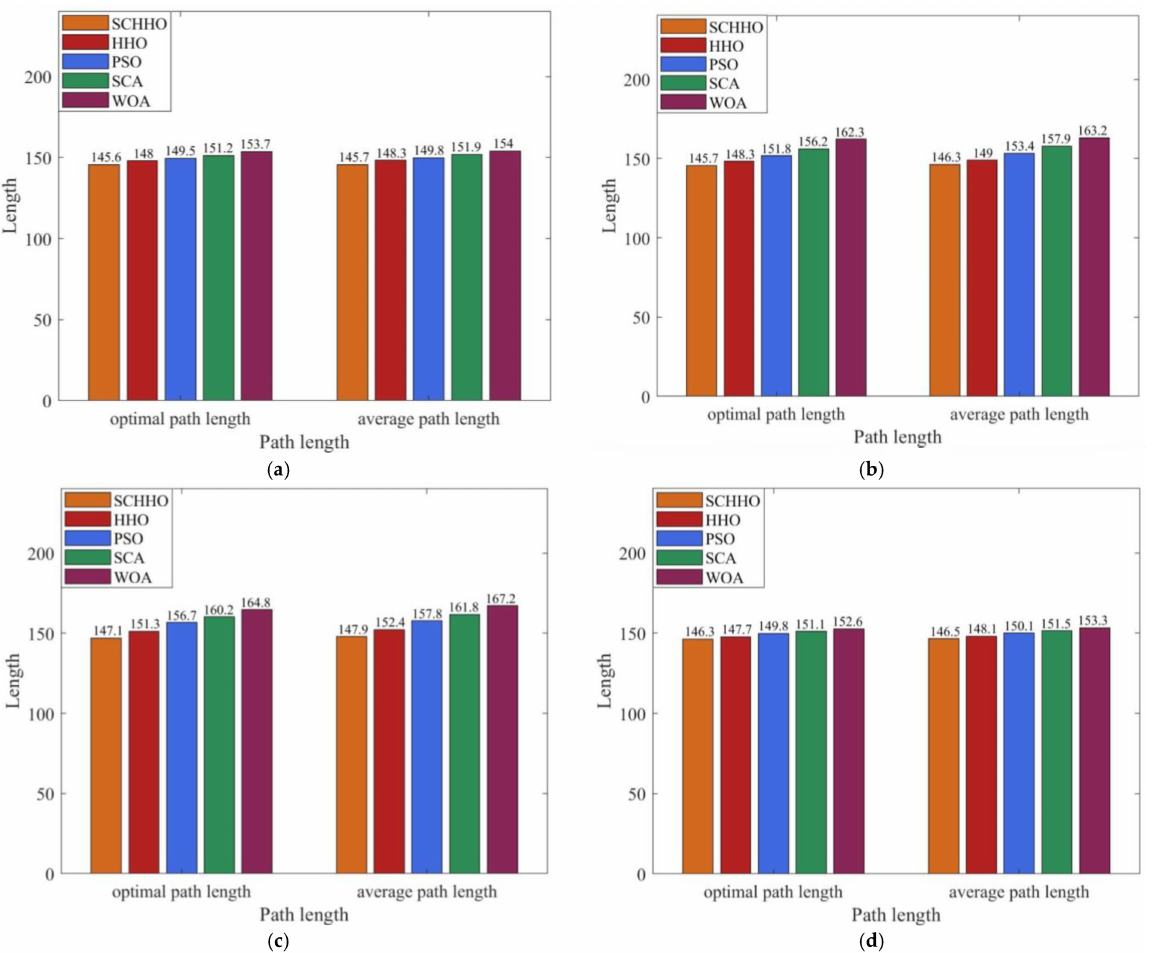
Figure 10. Path length comparison of five algorithms. ( a ) Case 1. ( b ) Case 2. ( c ) Case 3. ( d ) Case